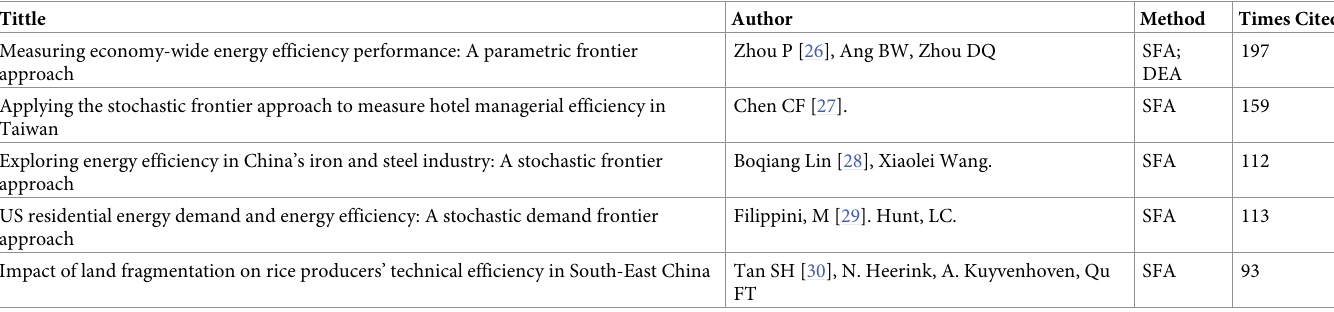
Table 2. Literature using stochastic frontier